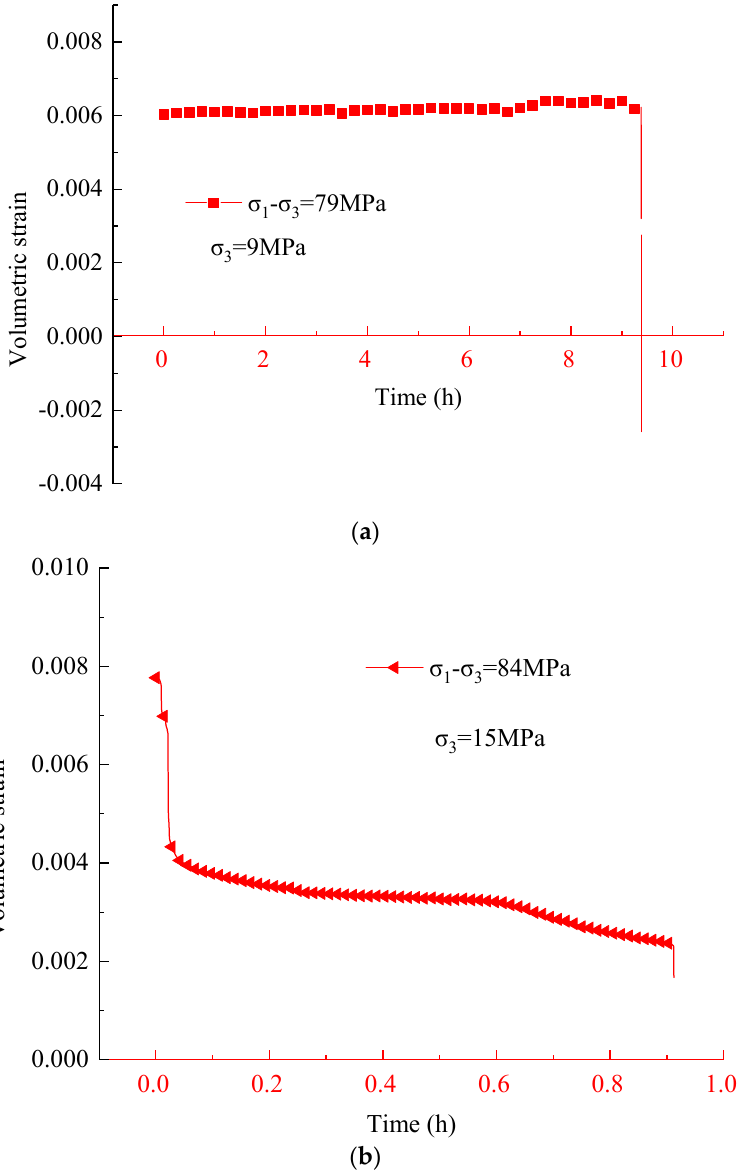
Figure 8. Creep curves of volumetric strain–time under the last deviatoric stress at confining pressures of ( a ) 9 MPa and ( b ) 15 MPa.